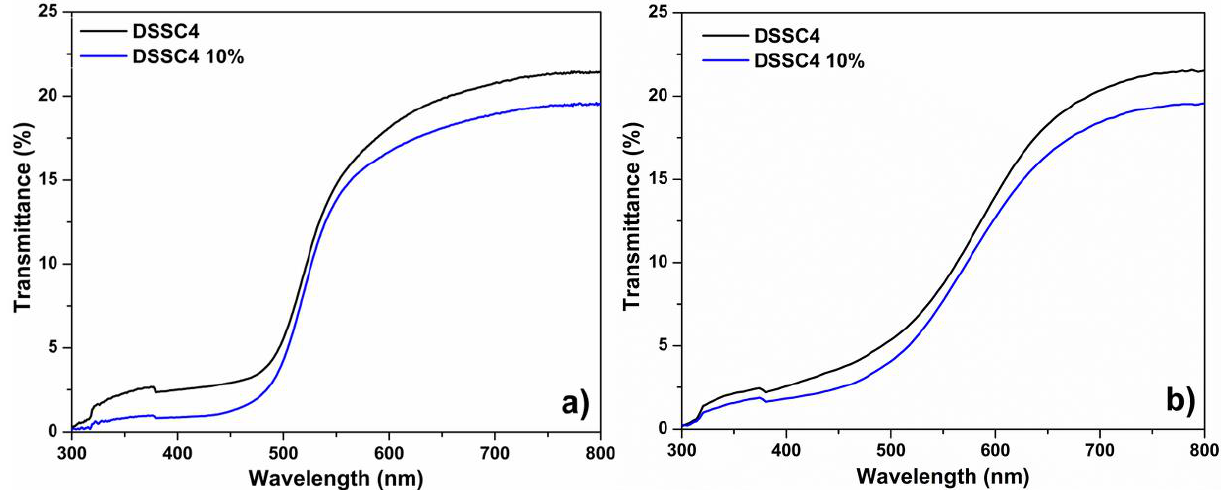
Figure 11. Transmittance spectra of ( a ) DN-F01and ( b ) curcumin-sensitized DSSC4 with E and E10% electrolytes.